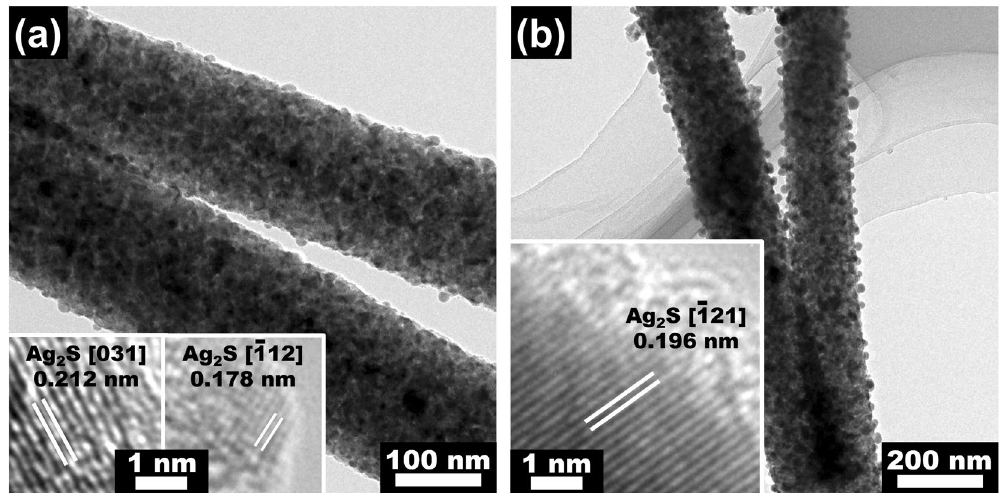
Figure 2. TEM images of ( a ) 11 nm-Ag 2 S@TiO 2 and ( b ) 23 nm-Ag 2 S@TiO 2 NFs. Insets are HR-TEM images near the nanofiber edges showing the lattice fringes of the Ag 2 S